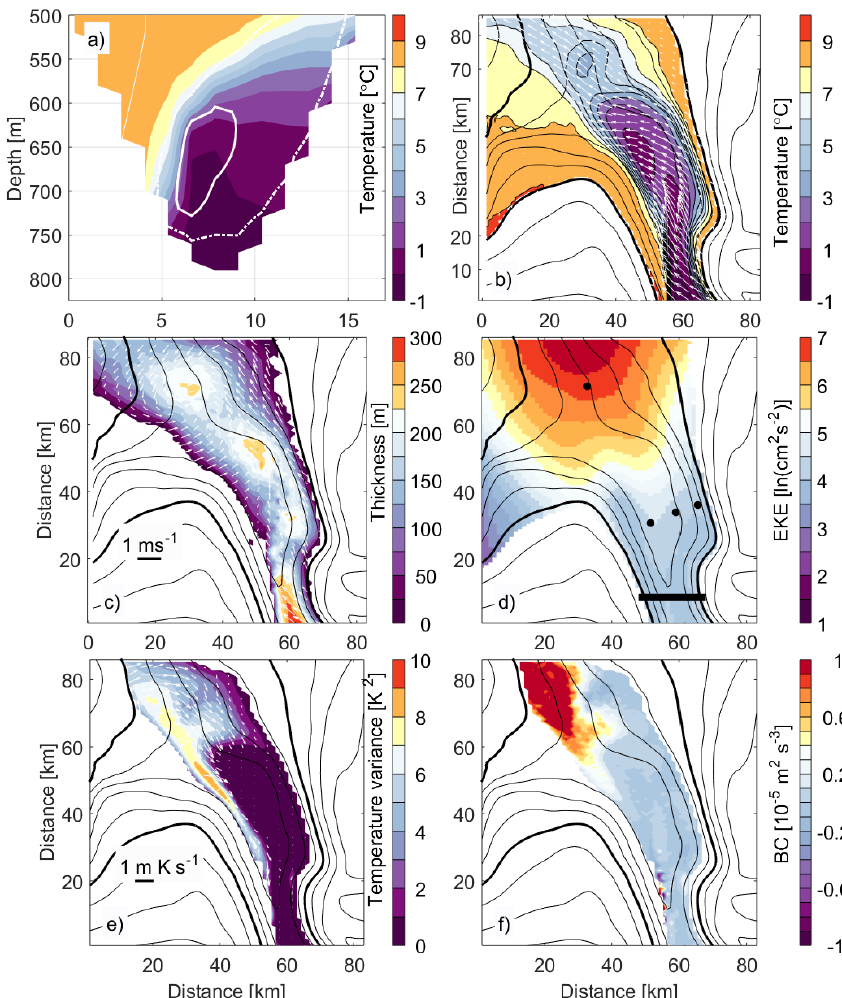
Figure 2. Modelled fields: (a) temperature (colour) and overflow velocity (white contours) at a section across the sill (thick black line in d ). The 0/0.5/1ms − 1 contours are marked with a thin/dotted/thick white line. (b) Mean temperature (colour) and velocity at 100mab (white arrows). (c) Snapshot of plume thickness (colour) and velocity at 500m depth from 10 August 2008 at 14:00UTC. The velocity scale given by the thick black line is valid for panel (b–c) . (d) Annual mean eddy kinetic energy (EKE, colour) at 300m depth. Note that the colour scale is logarithmic. The thick black line indicates the position of the section shown in (a) . (e) Temperature variance (colour) and divergent eddy heat flux (EHT, white arrows) at 100mab. (f) Baroclinic conversion rate (BC, colour). In panels (b–f) , the bathymetry is shown every 100m (thin black lines), while the 500 and 1000m isobaths are indicated by a thick black line. If not otherwise stated, the data shown are mean fields from August 2008. Only data from regions where the mean plume thickness is larger than 50m are included in (e–f) . For clarity, only data below 500m depth are included in (b) . The location of mooring C1–C3 and M is shown by black circles in (d)